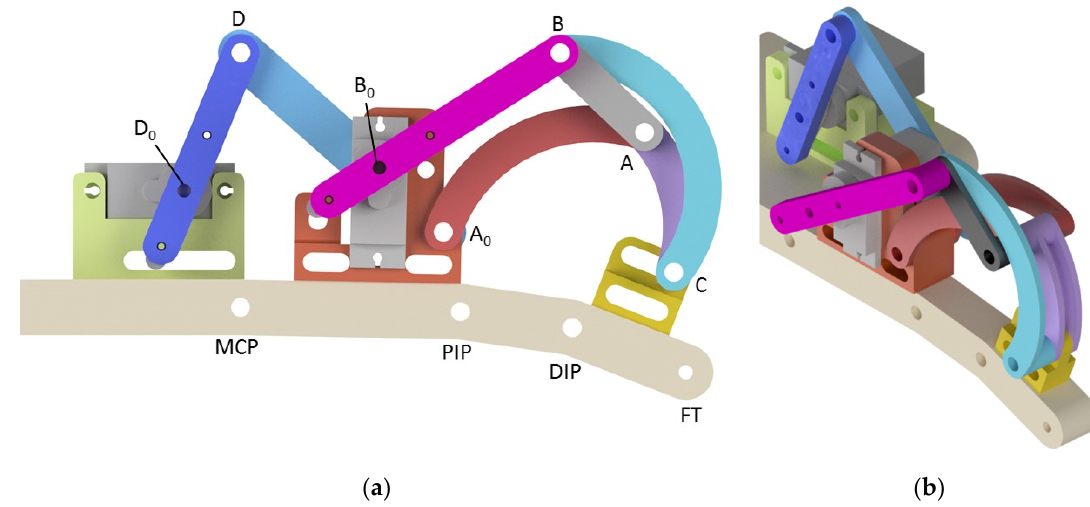
Figure 15. A CAD model of the finger exoskeleton including motors with description of joints ( a ) and angular view ( b ).